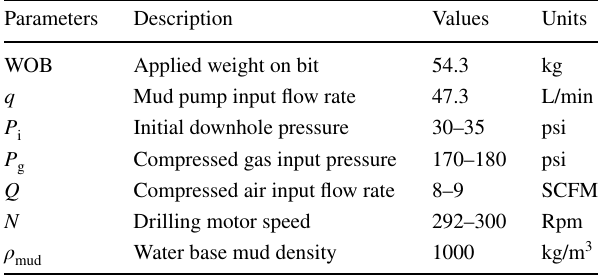
Table 2 Summary of input simulation